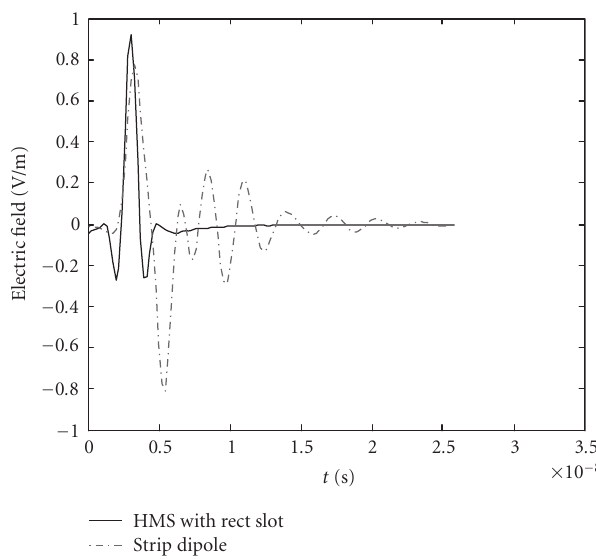
Figure 10: Transmitted waveform comparison between the HMS antenna and strip dipole.